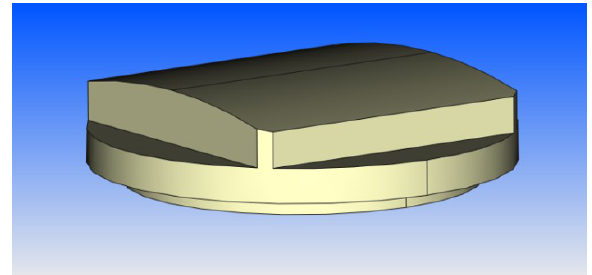
Fig. 1 Plano surface for alignment and circular boundary for centering. The plano surfaces in the XY plane can be used for